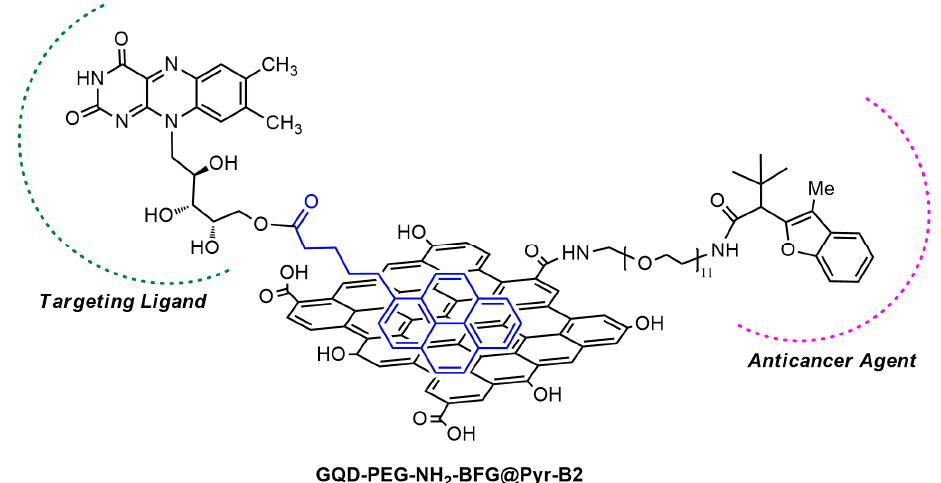
Figure 1. Cancer targeted drug delivery system (DDS) based on graphene quantum dots